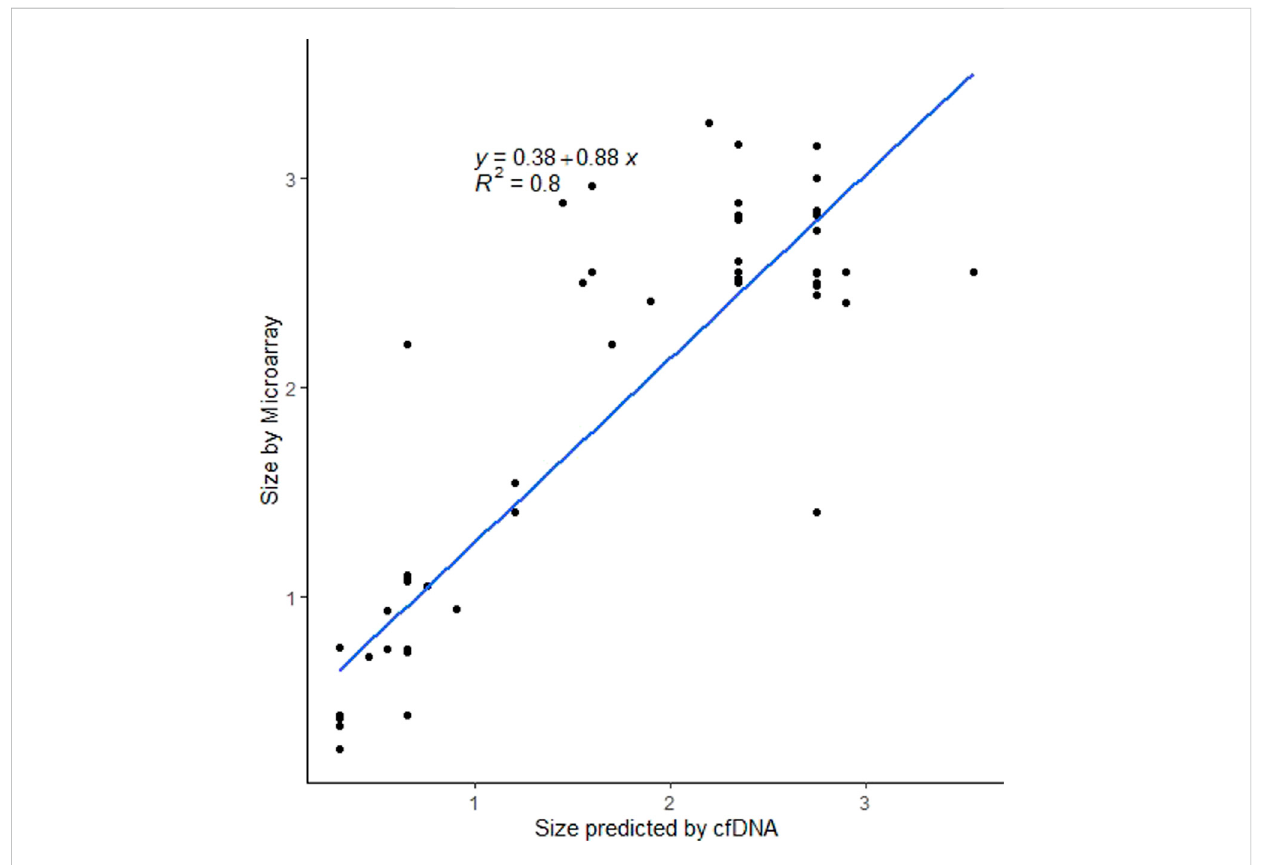
FIGURE 4 Scatterplot showing the relationship between estimated deletion size on cfDNA and con fi rmed deletion size on microarray.